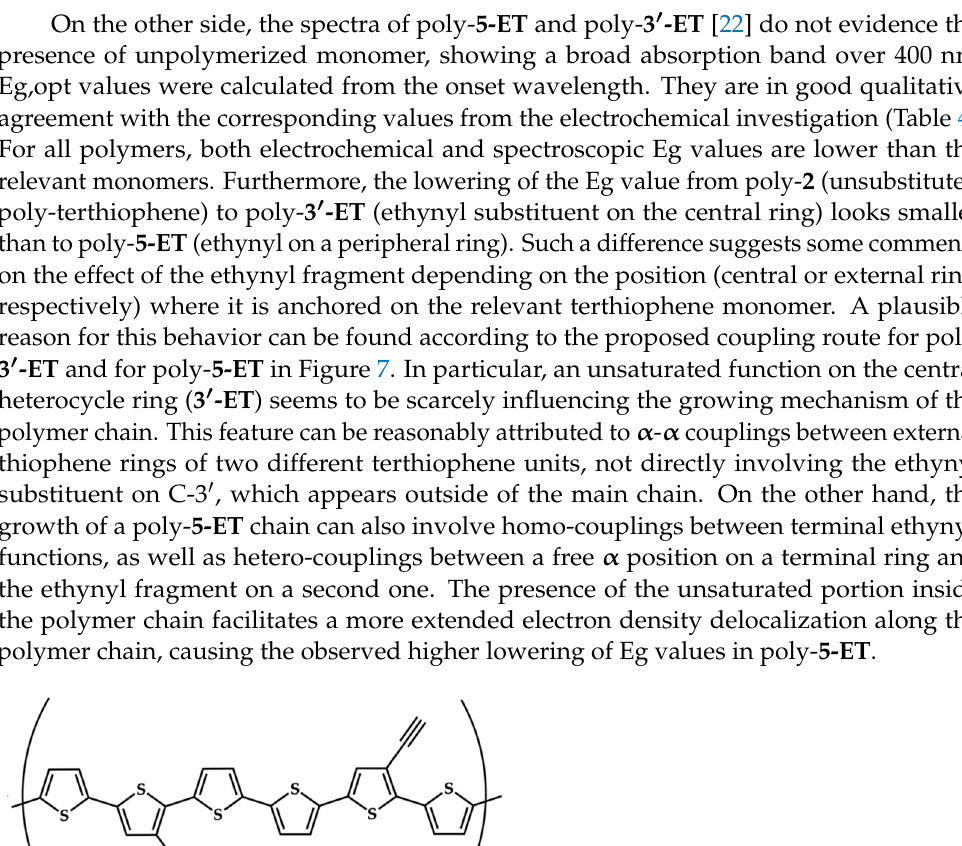
Figure 6. UV-Vis spectra of poly- 2 , poly- 3 , poly- 5-ET and poly- 3 ′ -ET on ITO.